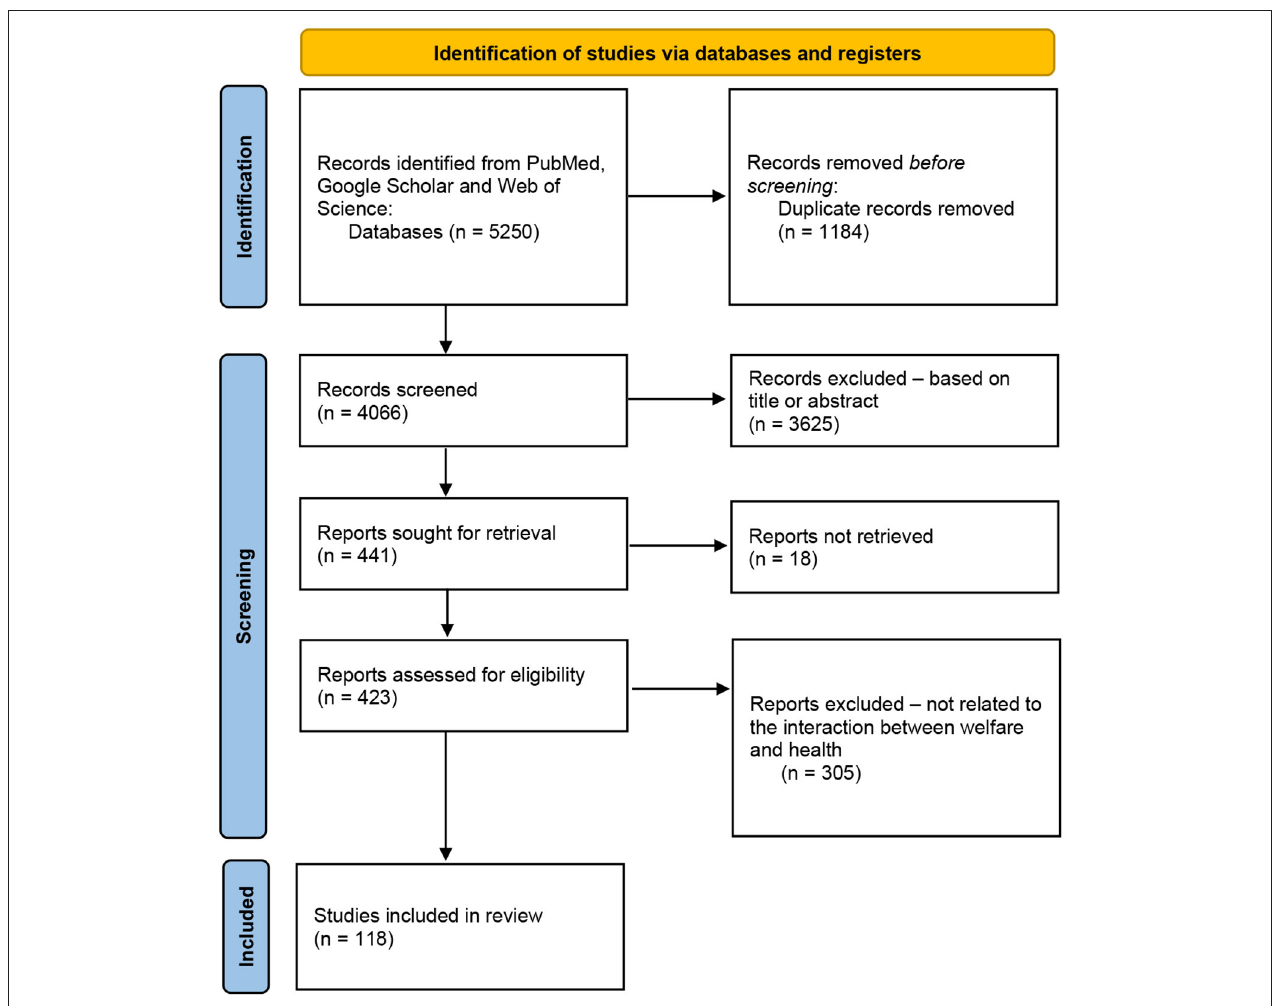
FIGURE 1 | Flow diagram of the steps followed in the search strategy